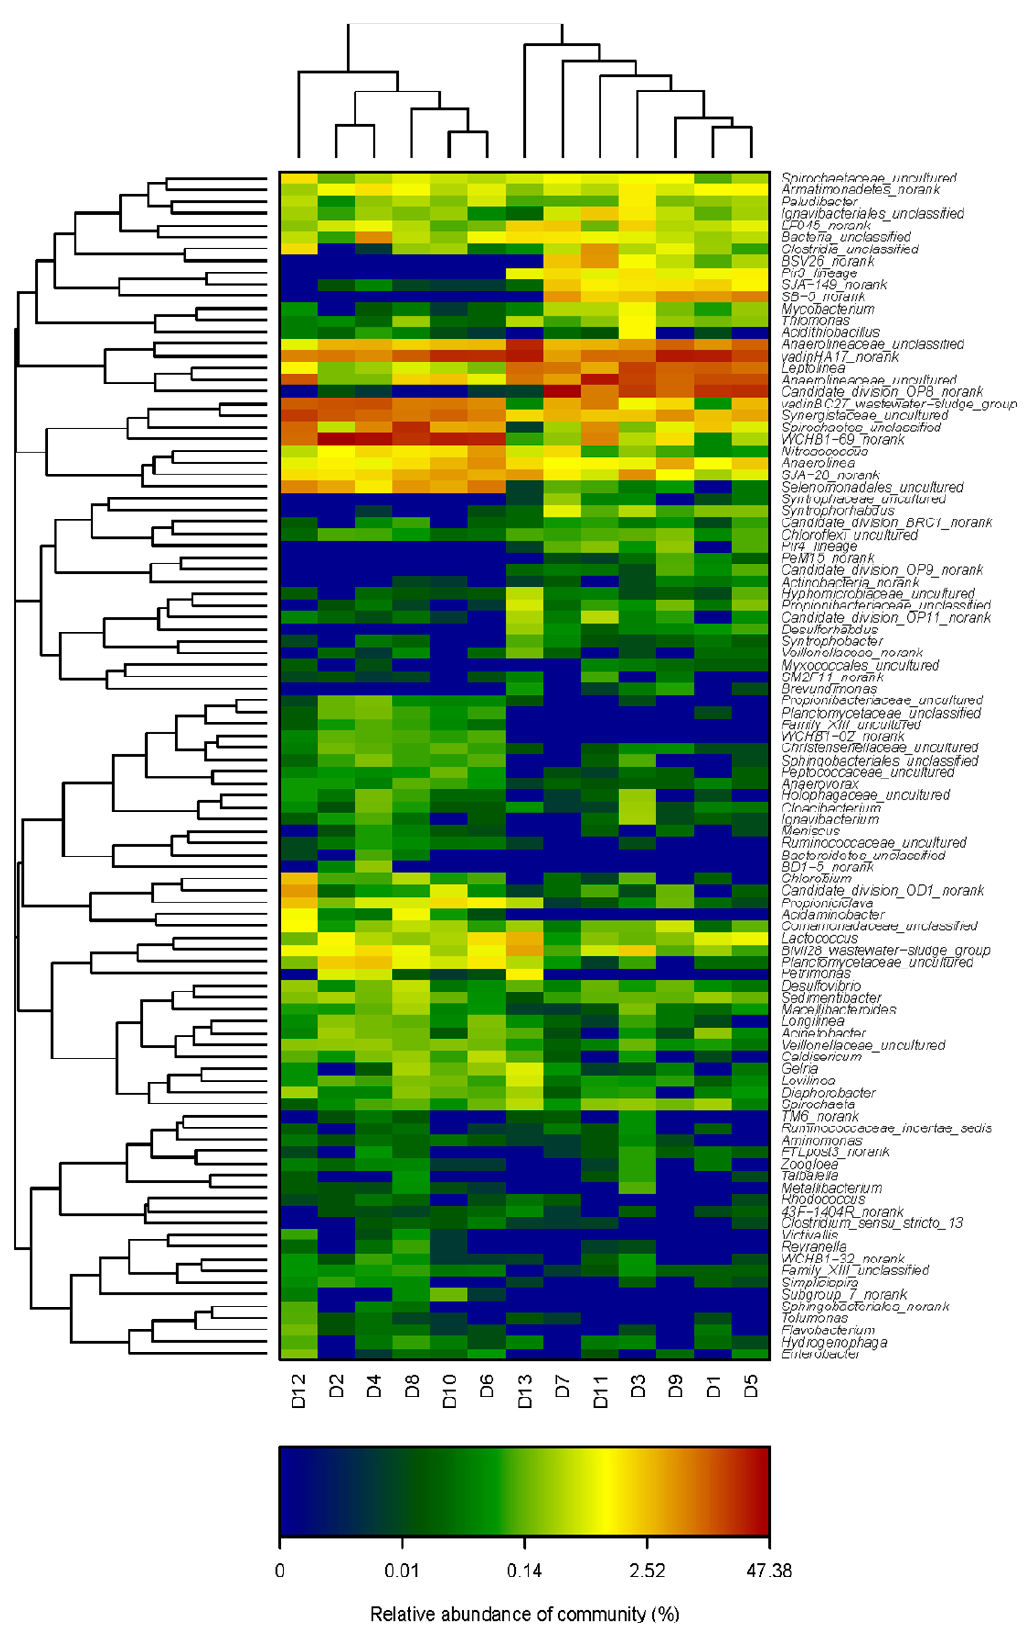
Figure 5. Heatmaps showed the percentages of the abundant species at the genus level within the bacterial communities of the bulk sludge and cake sludge in the M-AnMBR and